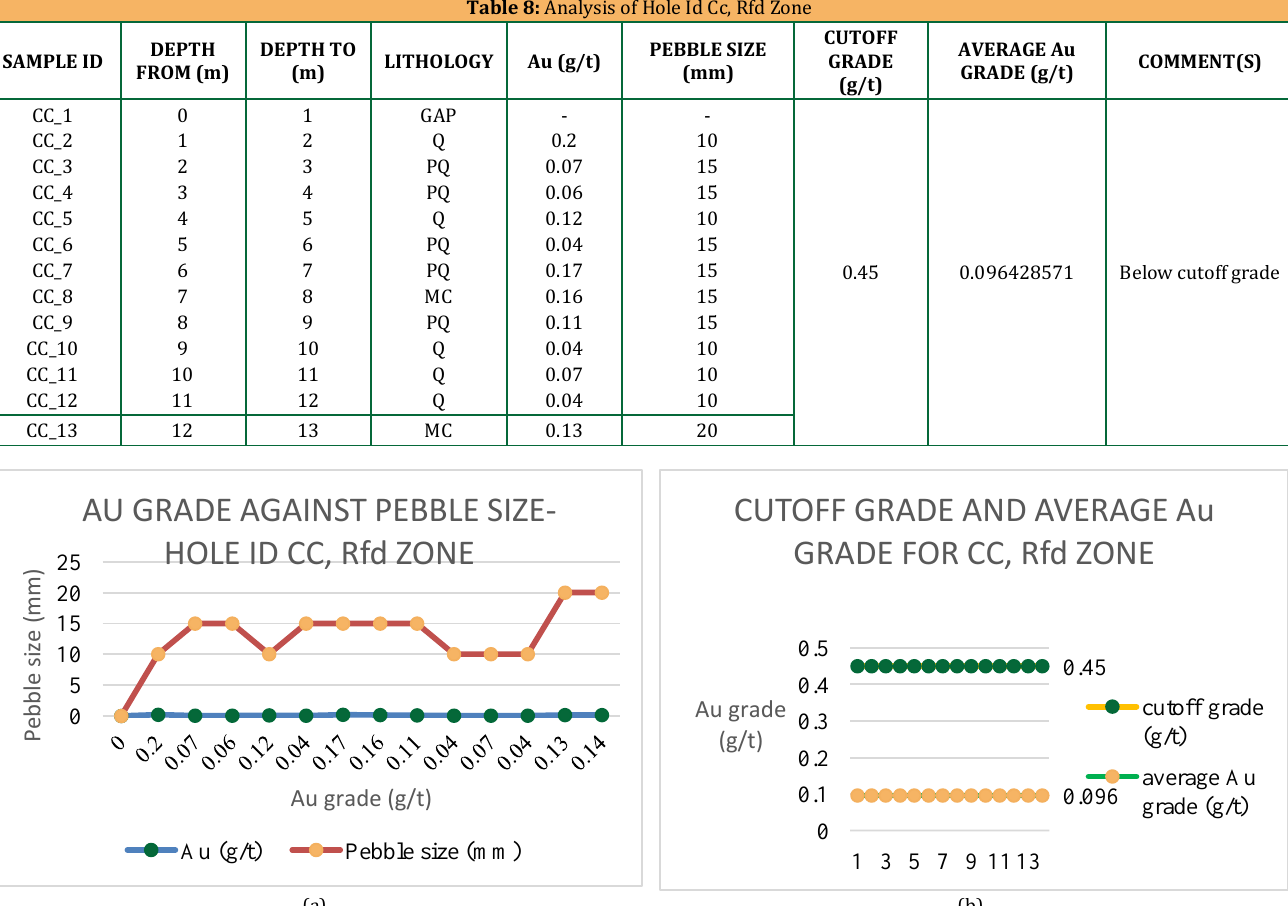
Table 8: Analysis of Hole Id Cc, Rfd Zone